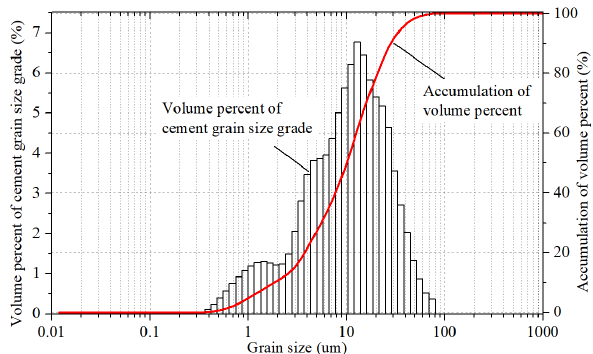
Figure 13. Grain size distribution of cement. Table 4. Initial strain and performance parameters of sand layer.